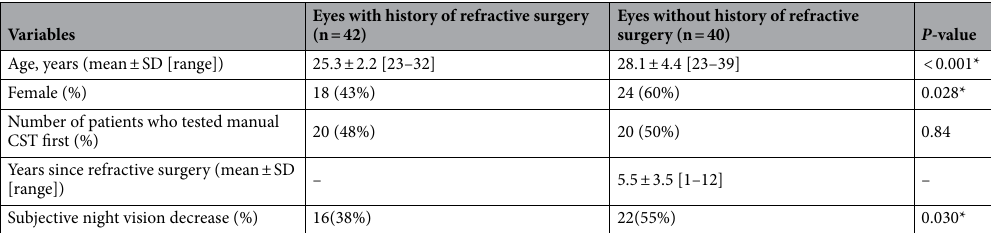
Table 1. Baseline characteristics of patients based on history of refractive surgery. *Indicates statistically significant